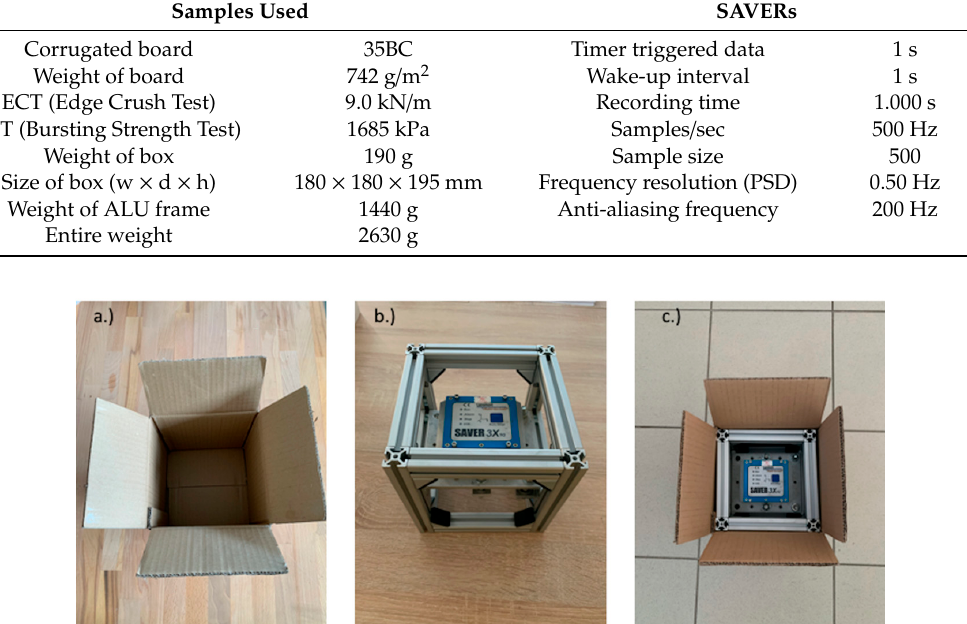
Table 1. Specifications for SAVER settings and samples used for this study. Samples Used